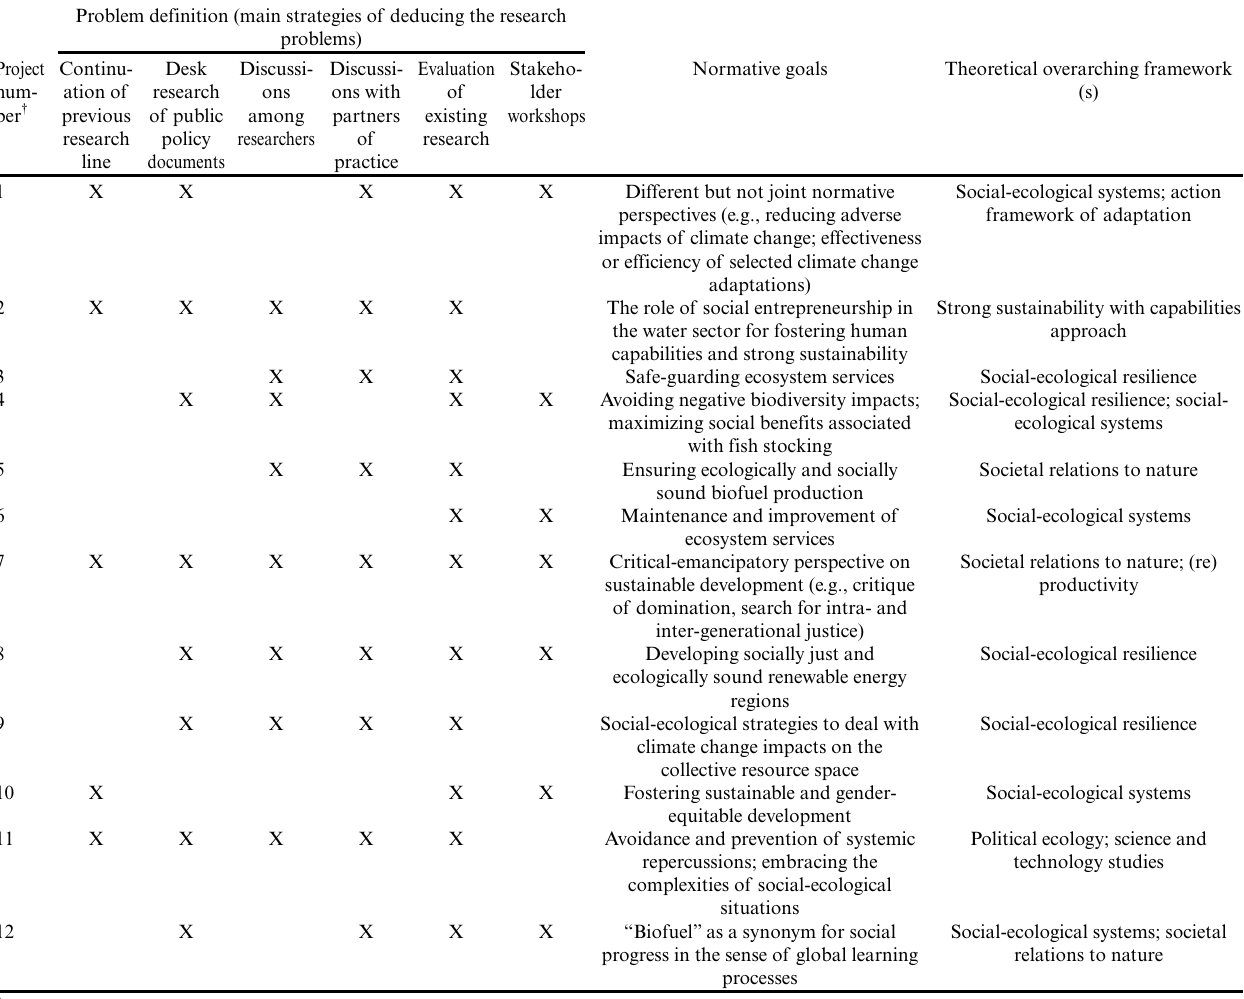
Table 2. Problem definition strategies, normative goals, and theoretical frameworks of the 12 social-ecological research groups. Problem definition (main strategies of deducing the research